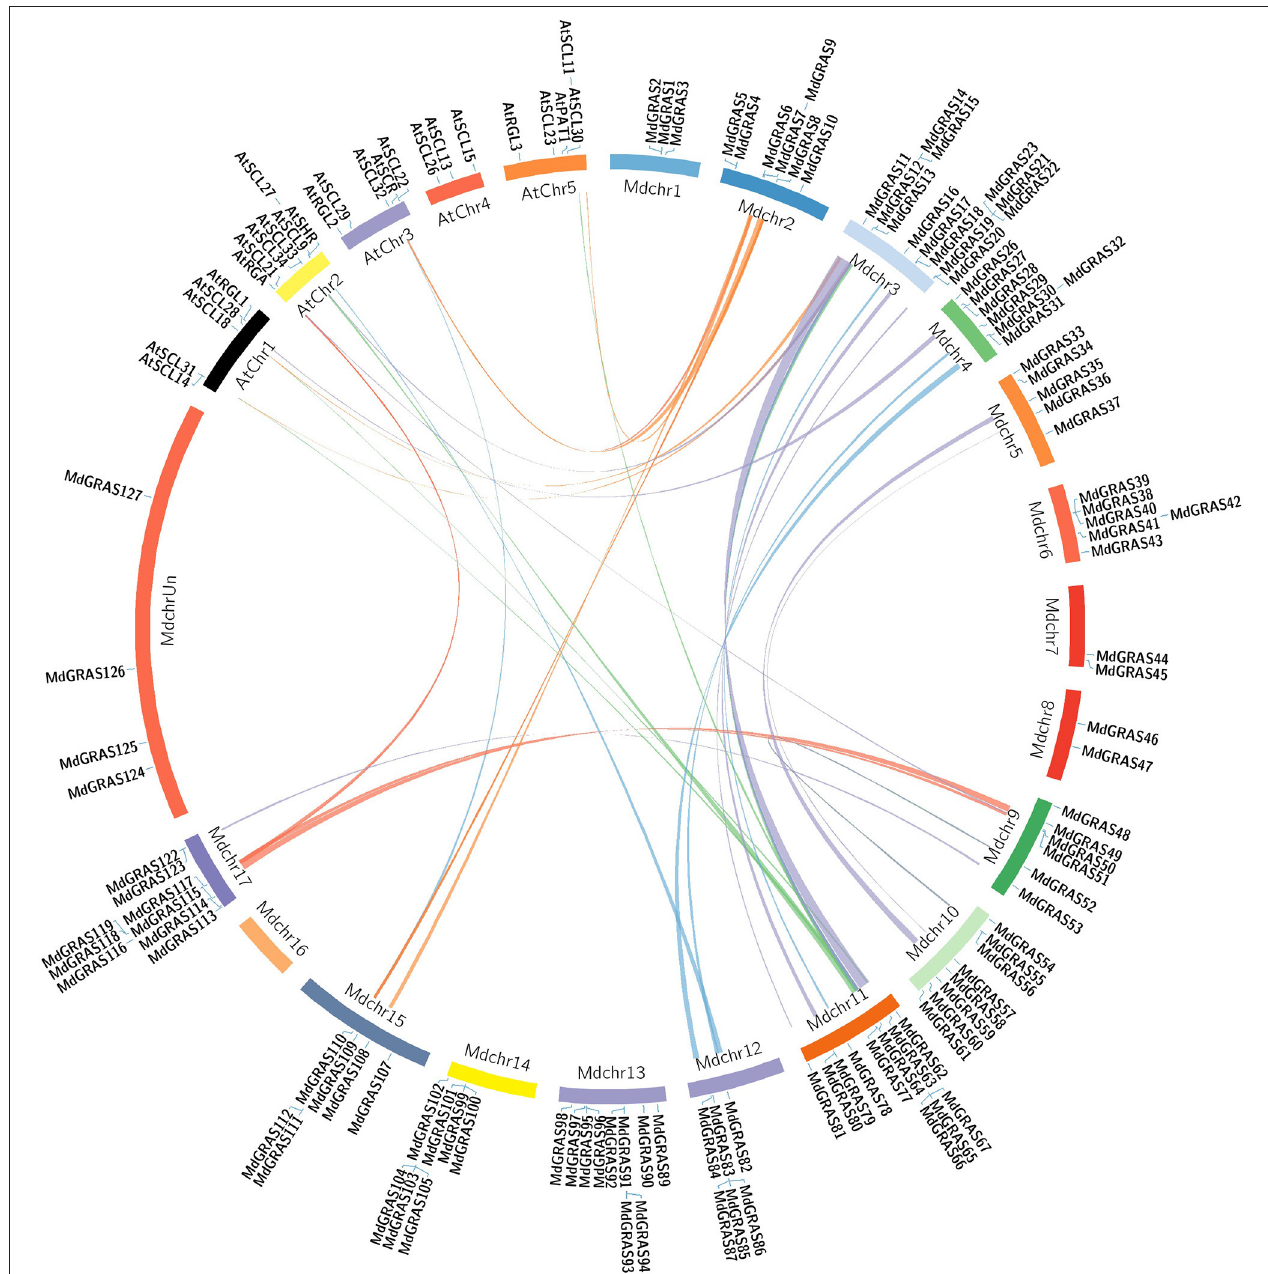
FIGURE 4 | Syntenic relationships between apple and Arabidopsis GRAS genes. Colored curves represent apple and Arabidopsis syntenic gene regions.